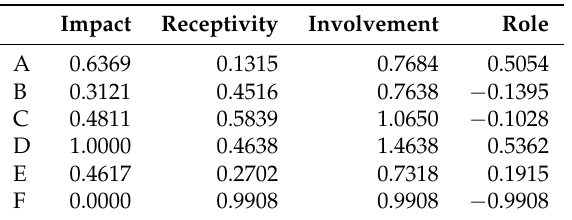
Table A2. The WINGS output for illustrative example—absolute values.